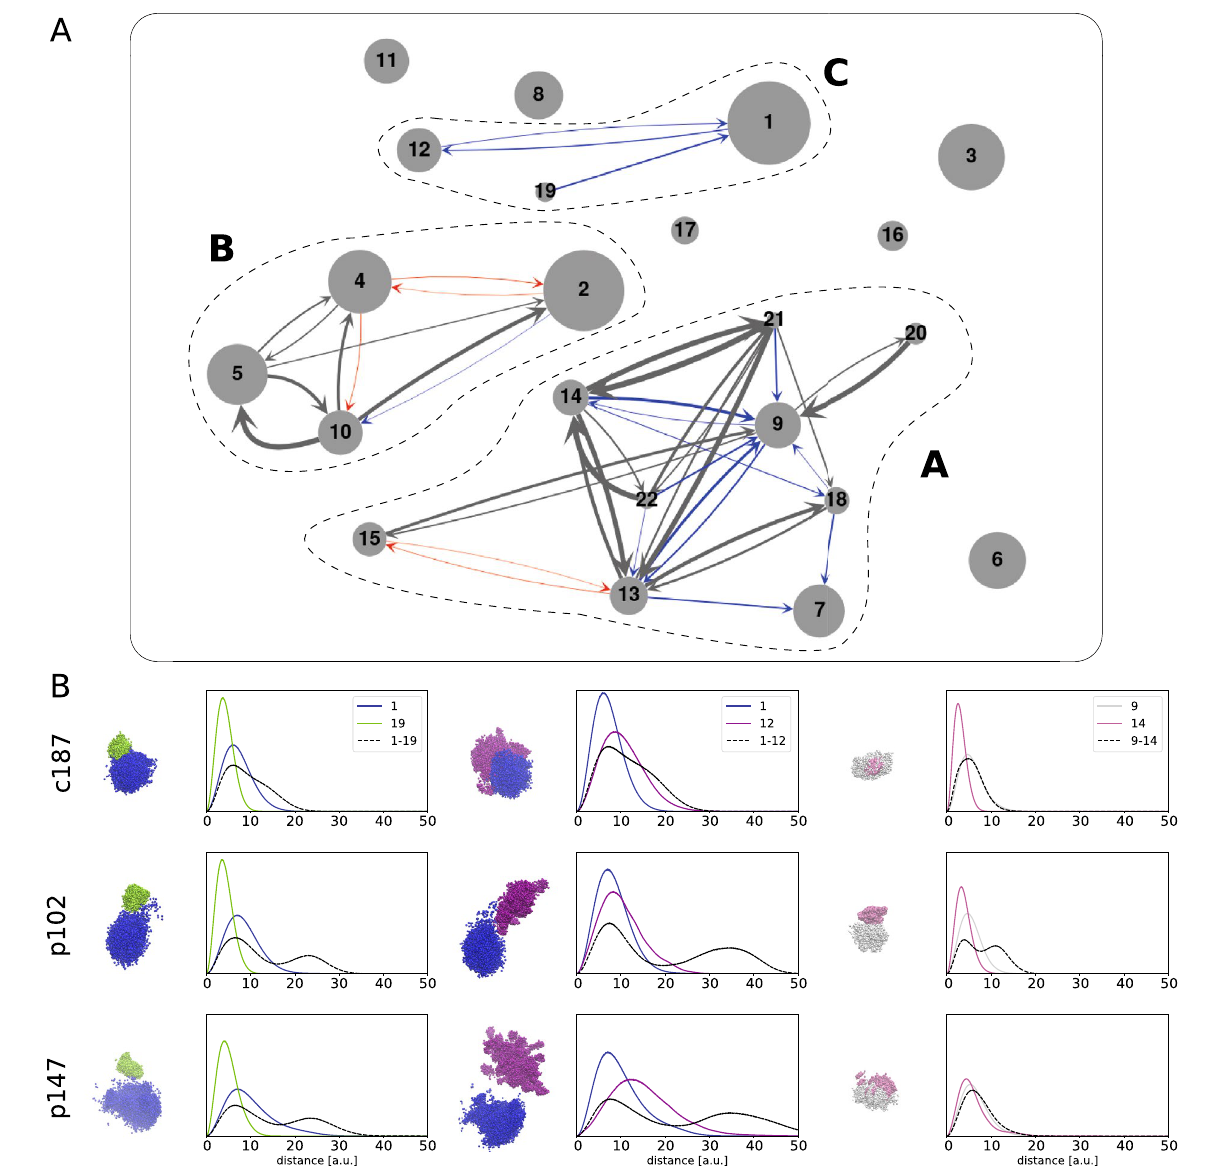
Figure 2. Differences in chromosomal intermingling between control and patient samples. ( A ) Chromosomal intermingling network in the ensemble reconstructions. Chromosomes are represented as nodes with radius scaling with chromosome size. Edges connect chromosomal pairs that intermingle strongly in all controls only (blue), all patients only (red), or in all controls and patients (grey); edge width represents the average mixing fraction observed in corresponding samples. Three chromosomal groups can be identified in the network, as marked by dashed lines. ( B ) Typical chromosomal morphology and distance correlation functions g ( r ) of chromosome pairs 1–19, 1–12, and 9–14 in controls and patients. Chromosomes adopt the same color convention as in Fig. 1: 1 – blue, 9 – white, 12 – purple, 14 – pink, 19–lime